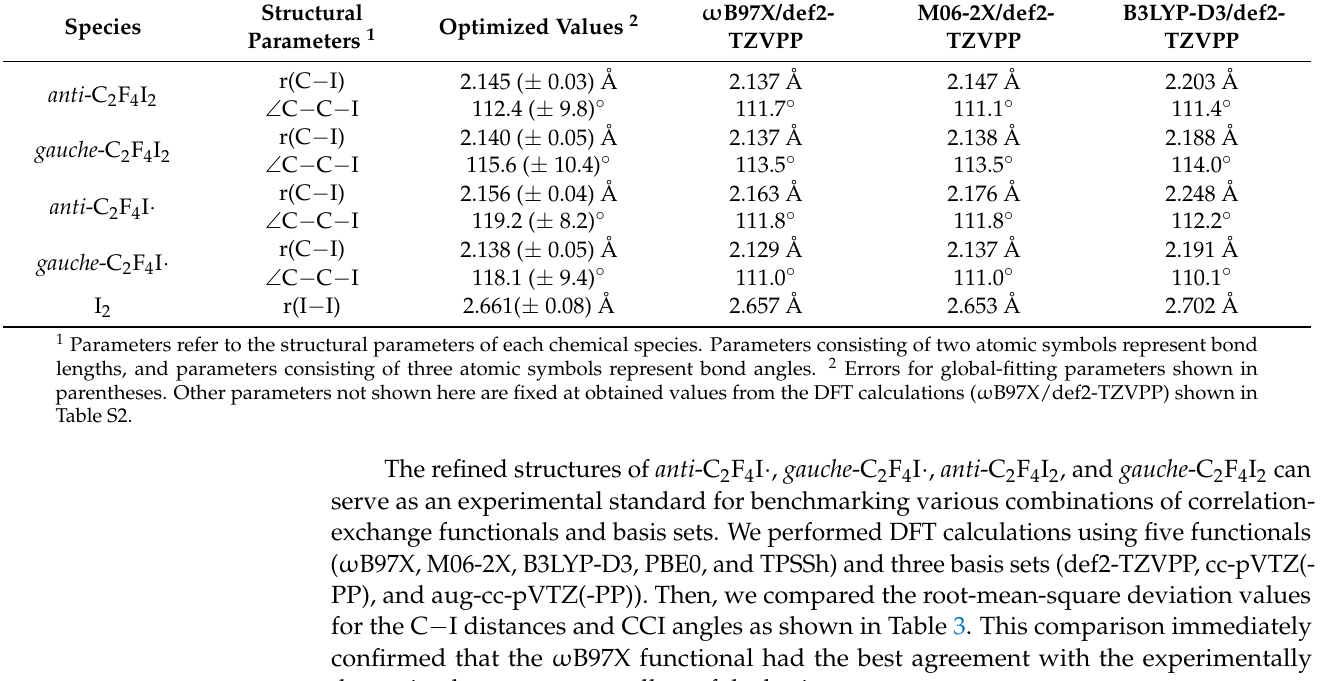
Table 2. Key structural parameters of chemical species from global-fitting analysis in comparison with those from DFT calculations performed with various functionals.